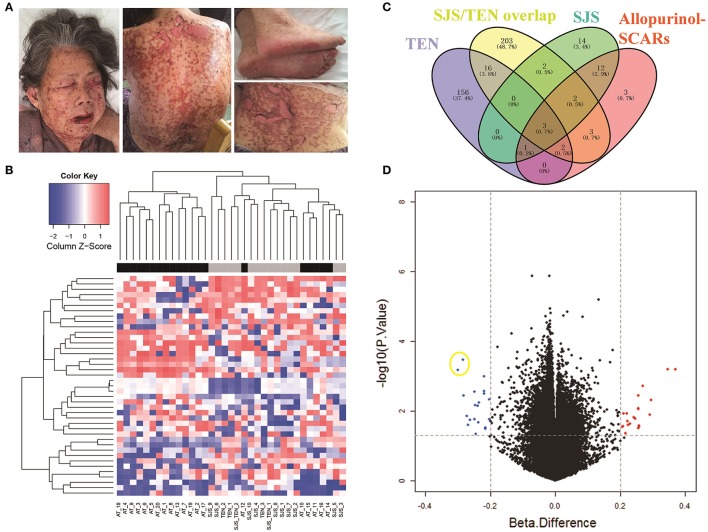
Identification of DNA methylation difference between allopurinol-SCARs and allopurinol-tolerant controls. (A) Dermatological manifestations of one featured SJS/TEN overlap patient. The patient has given written consent for the publication of her images. As showed, 10–30% of the total body surface area was involved. Mucocutaneous sloughing was observed in the mouth, eyes and genital area. Epidermal detachment in the face, neck, back and extremities was observed. (B) Two-dimensional hierarchical clustering was performed using the statistical variable DNA methylation probes across all samples (n = 35). Probes are in rows; samples are in columns. (C) Venn diagram showed the overlaps of methylated genes in different phenotypes of allopurinol-SCARs. (D) Volcano plot of the differential DNA methylation analysis. X-axis denotes β-value differences; Y-axis denotes P-values for each probe (-log10 scale). Vertical dotted lines denote 20% change in β-values; horizontal dotted line denotes the significance cutoff. Two hypomethylated dots in yellow circle are the probes of cg08412936 (up) and cg24926791 (down) in PSORS1C1 promoter area.